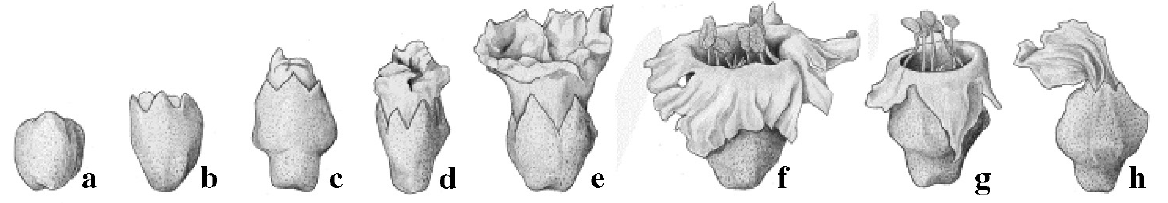
Figure 2 - Development of Varronia curassavica Jacq. flower bud a. flower bud; b. disruption of sepals (night before anthesis); c. start of anthesis , stigmata receptive (6:00 am); d. corolla exposed and lobes closed (start of pollen and nectar secretion (7:00 am); e. expansion and separation of lobes; f. flower completely open (9:00 am); g. beginning of wilting and floral oxidation (2:00 pm); h. flower completely oxidized (6:00 pm). Illustration: Leandro Lopes de